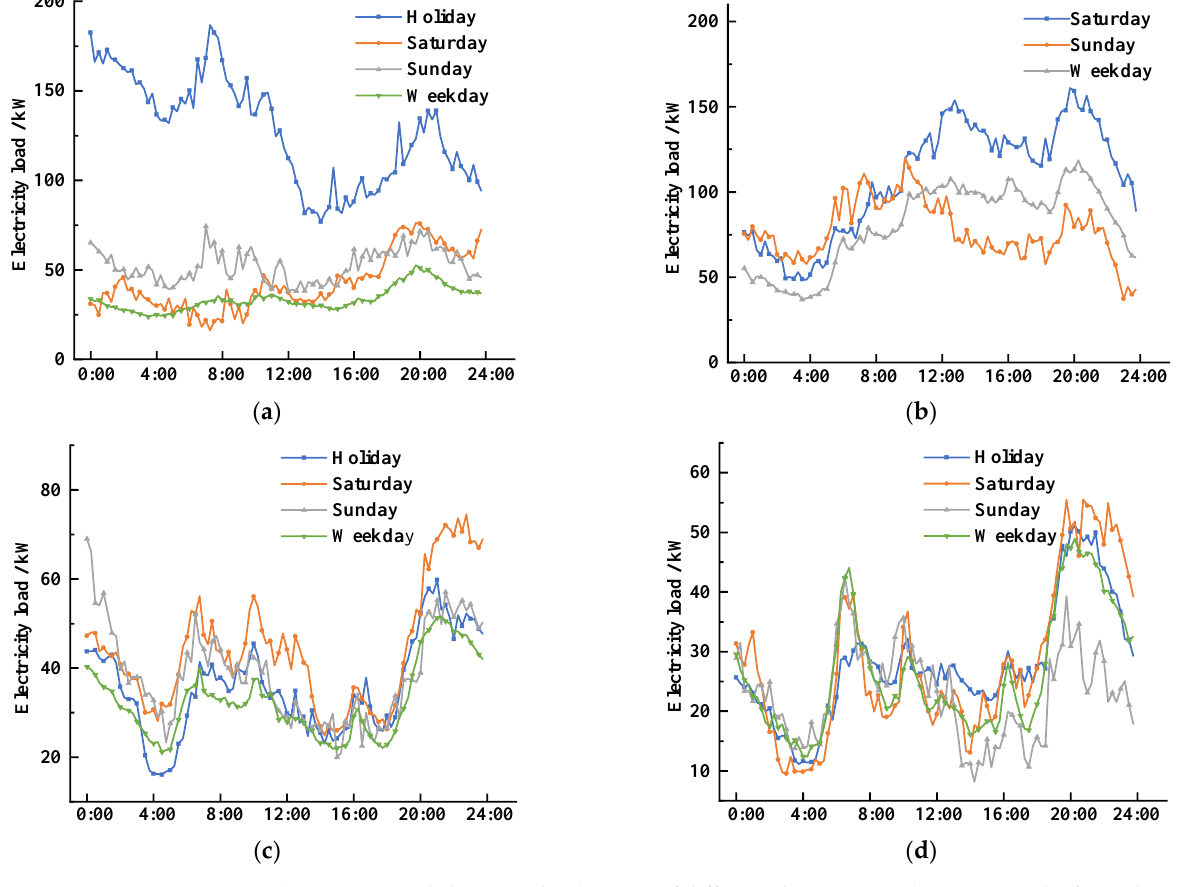
Figure 5. Typical electricity load curves of different day types : ( a ) heating month; ( b ) cooling month; ( c ) transition month (first half of the year); ( d ) transition month (second half of the year).